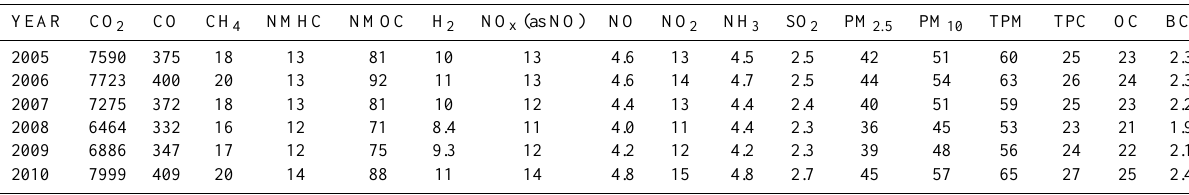
Table 6. Global annual emissions (Tg-Speciesyr − 1 ) from FINNv1.